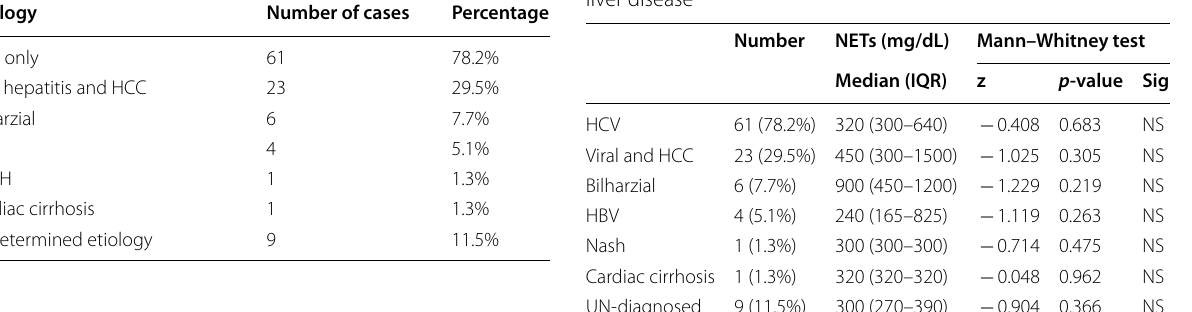
Table 3 Relation between NET levels and etiology of chronic liver